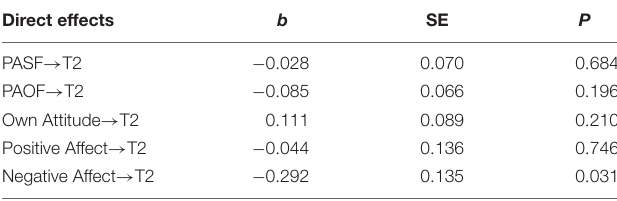
TABLE 3 | Determinants of hookup partners ( N =